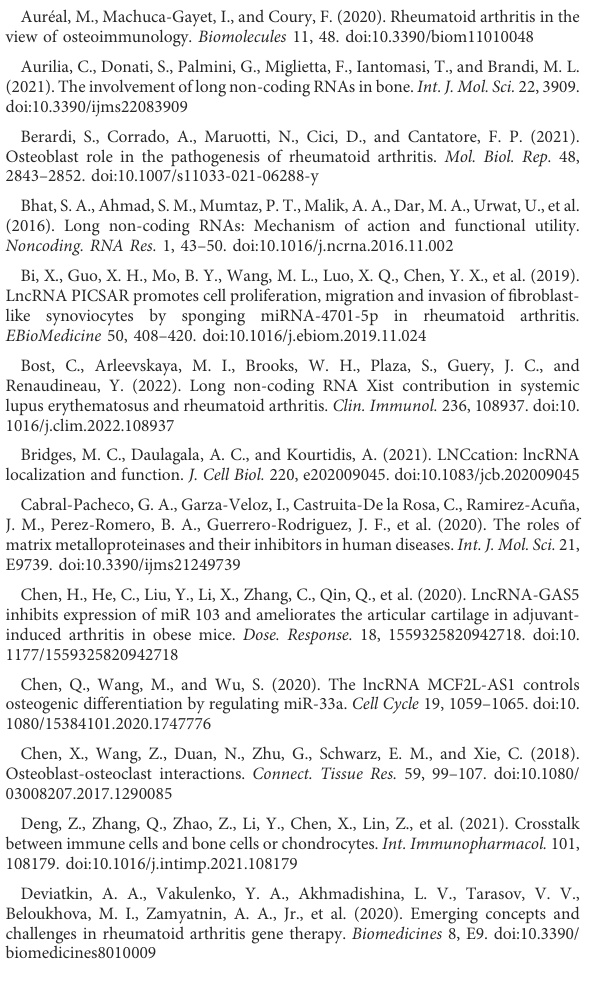
(Table 1 and Figure 1). LncRNAs can serve as potential biomarker and therapeutic target for RA joint